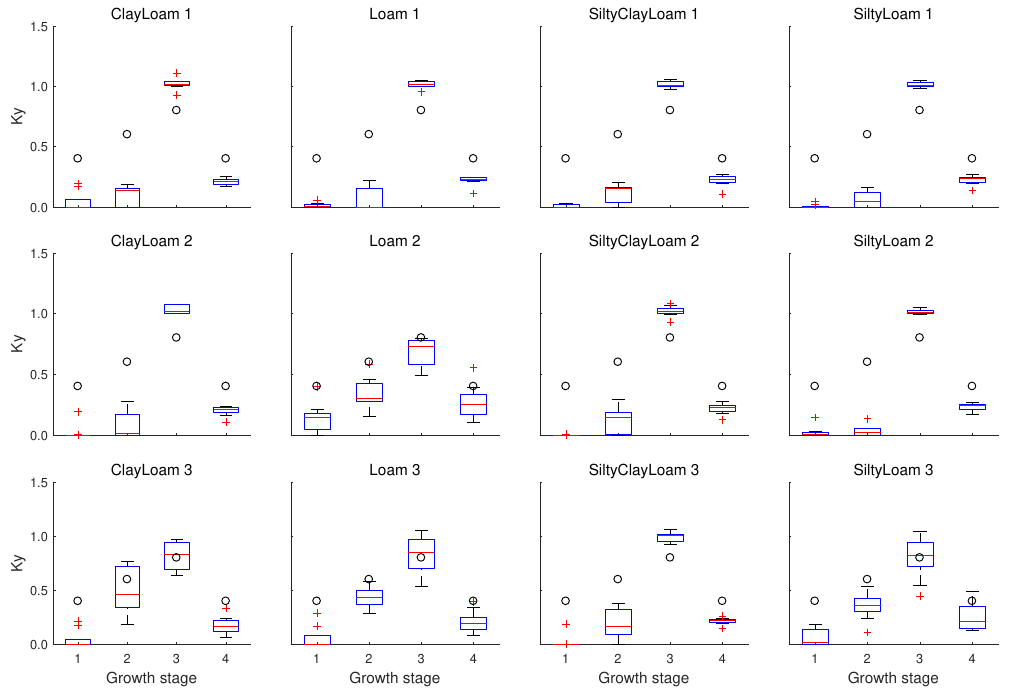
Figure 7. Yield response factor ( Ky ) obtained for wheat for every soil type considering the benchmark process. Circles represent Ky values proposed by the FAO